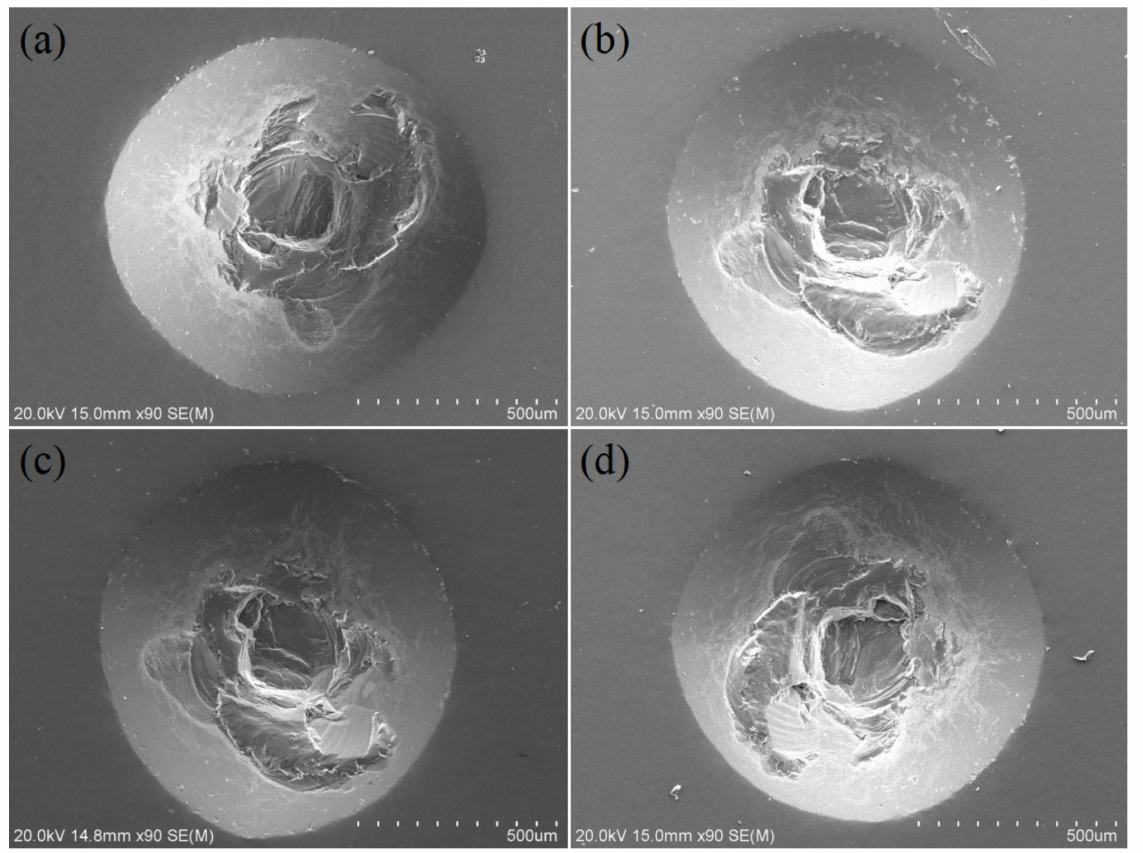
Figure 7. SEM micrograph indentation morphologies of Ti-DLC coatings at different bias voltages after Rockwell C tests: ( a ) − 50 V; ( b ) − 100 V; ( c ) − 200 V, and ( d ) − 300